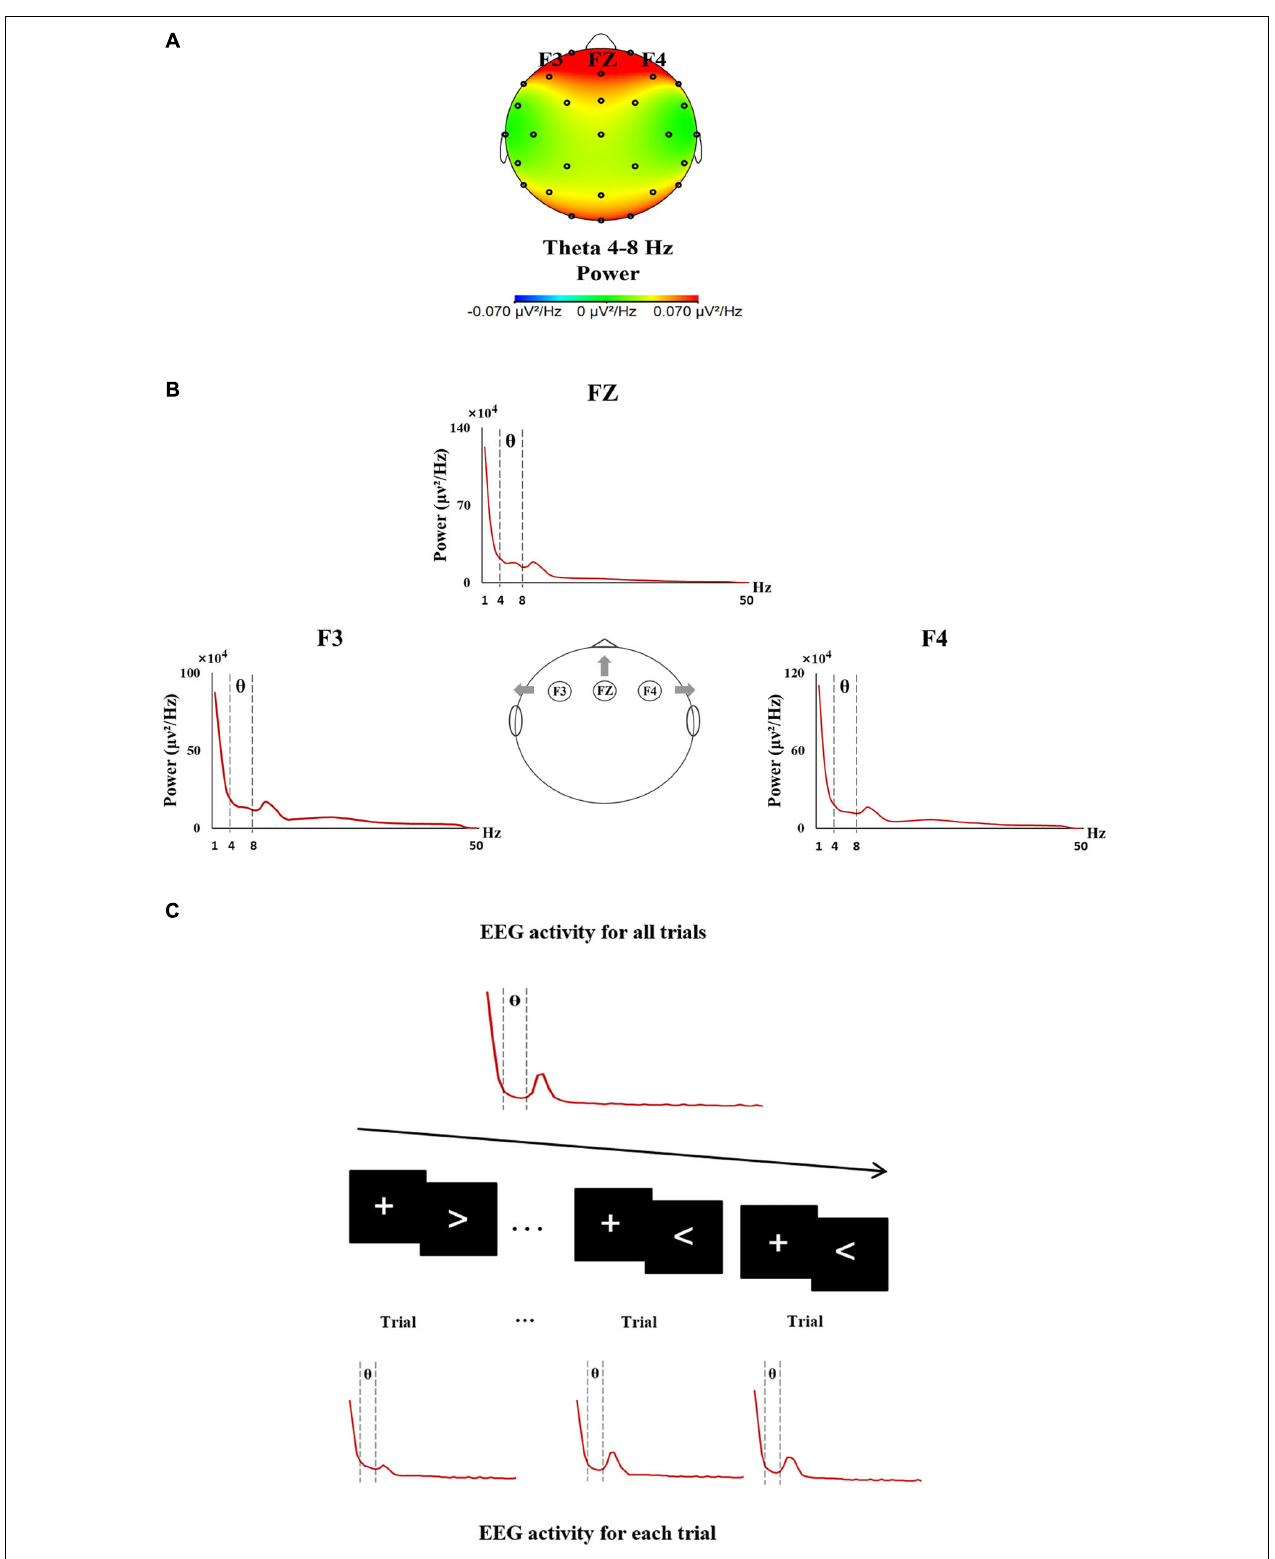
FIGURE 1 | The procedure of EEG data analyses. (A) EEG topographic map showing the theta activity mainly located in the frontal area during the sustained attention task. (B) Frontal theta EEG activity was analyzed from 4 to 8 Hz at F3, FZ, and F4. (C) The procedure of the trial-by-trial analysis of EEG activity.